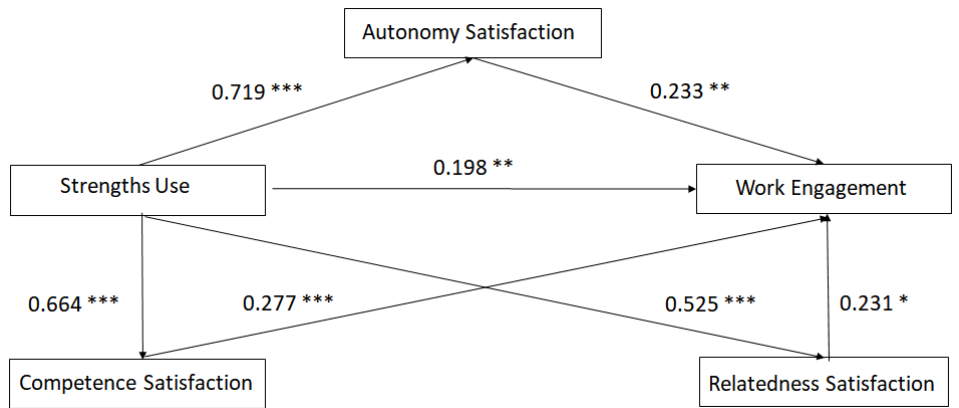
Figure 1. Needs satisfaction mediates the connection between strengths use and work engagement. * p < 0.05; ** p < 0.01; *** p < 0.001.